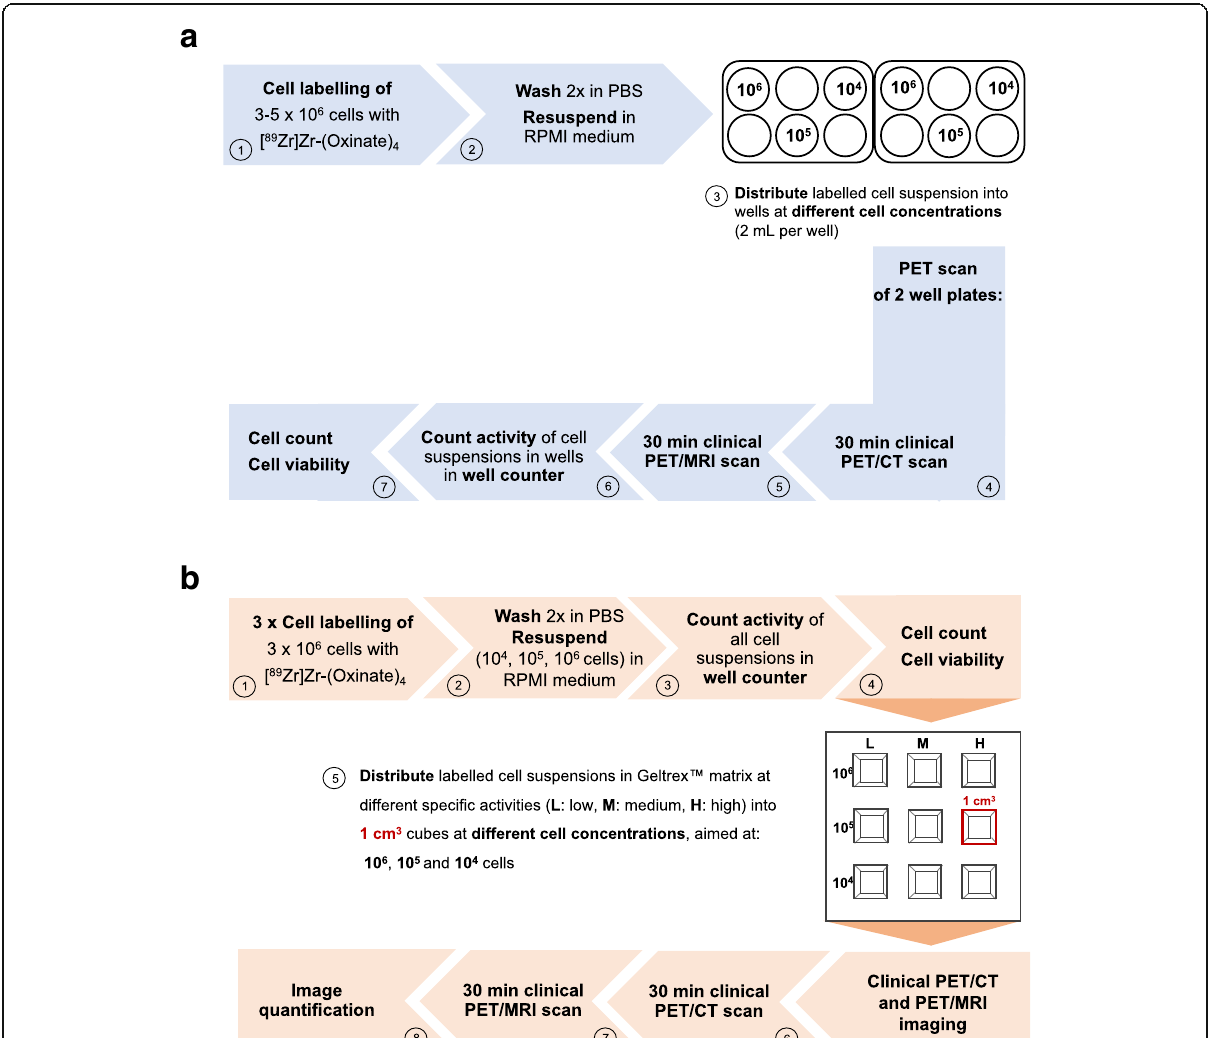
Fig. 1 Schematic overview of the setup for the a 6-well plate experiments and b 3 x 3 cubic-well plate